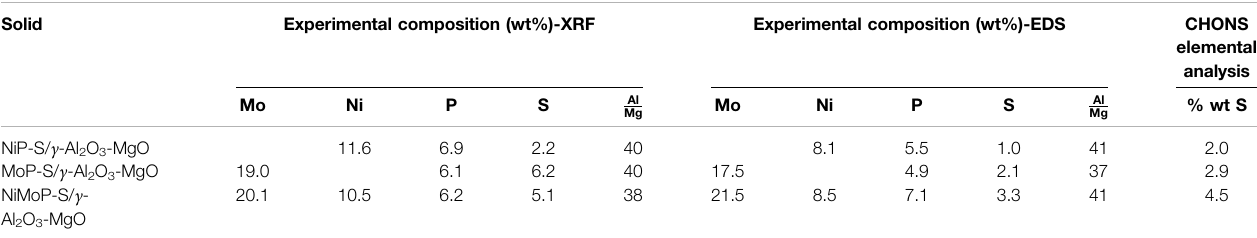
Solid Experimental composition (wt%)-XRF CHONS